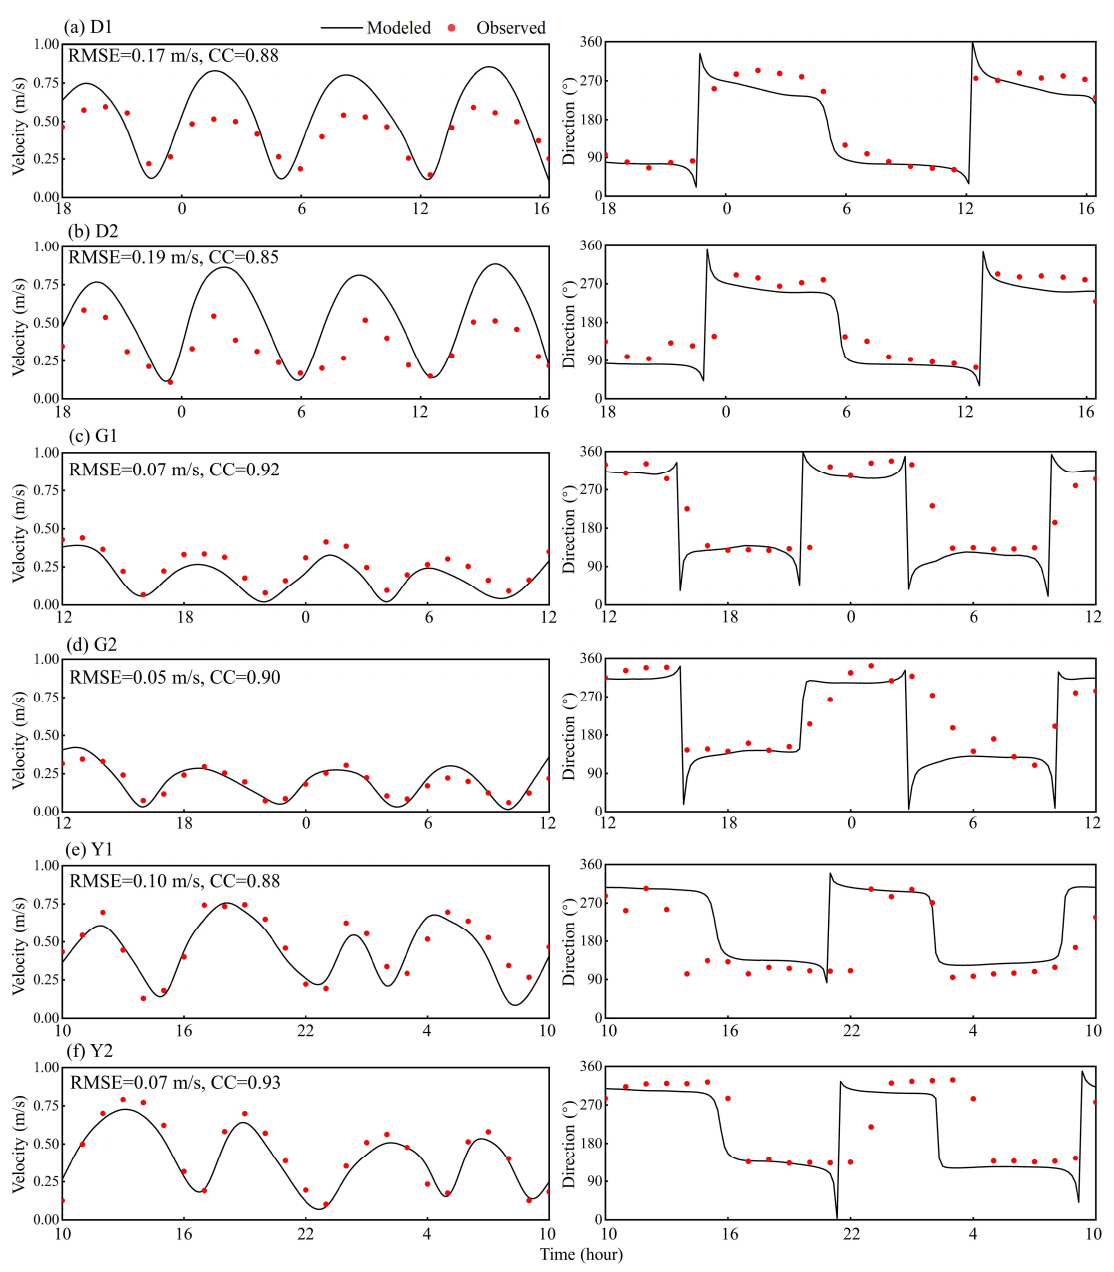
Figure 5. Comparison of modeled and observed flow velocities and directions at six observation sites: ( a ) D1, ( b ) D2, ( c ) G1, ( d ) G2, ( e ) Y1, and ( f ) Y2.